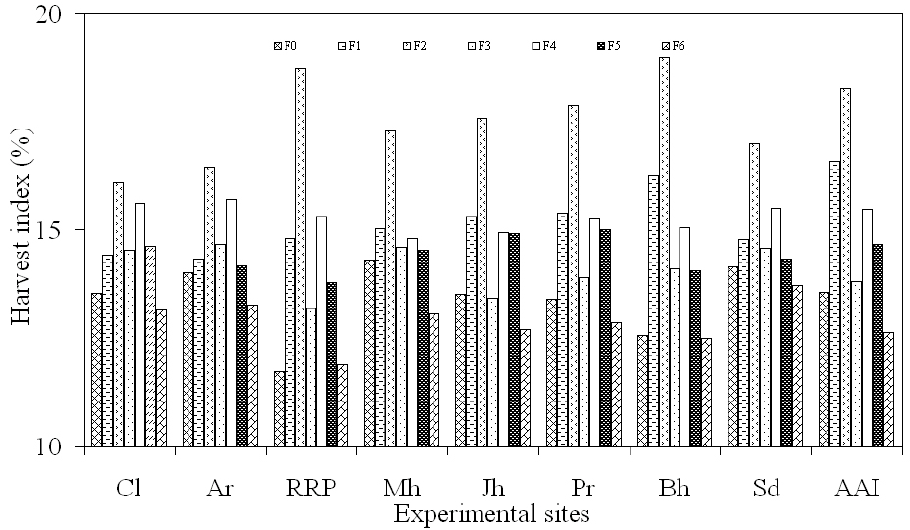
FIGURE 5 . Effect of different fertility levels on harvest index of wheat plants grown at various sites.